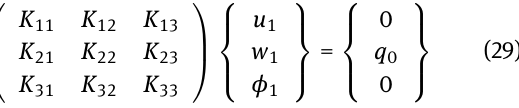
Navier’s solution procedure is adopted to determine un- known displacement variables ( u 0 , w 0 and ϕ ). The fol- lowing is the solution form assumed for displacement vari- ables u 0 , w 0 and ϕ satisfying the simply supported bound- ary conditions exactly.